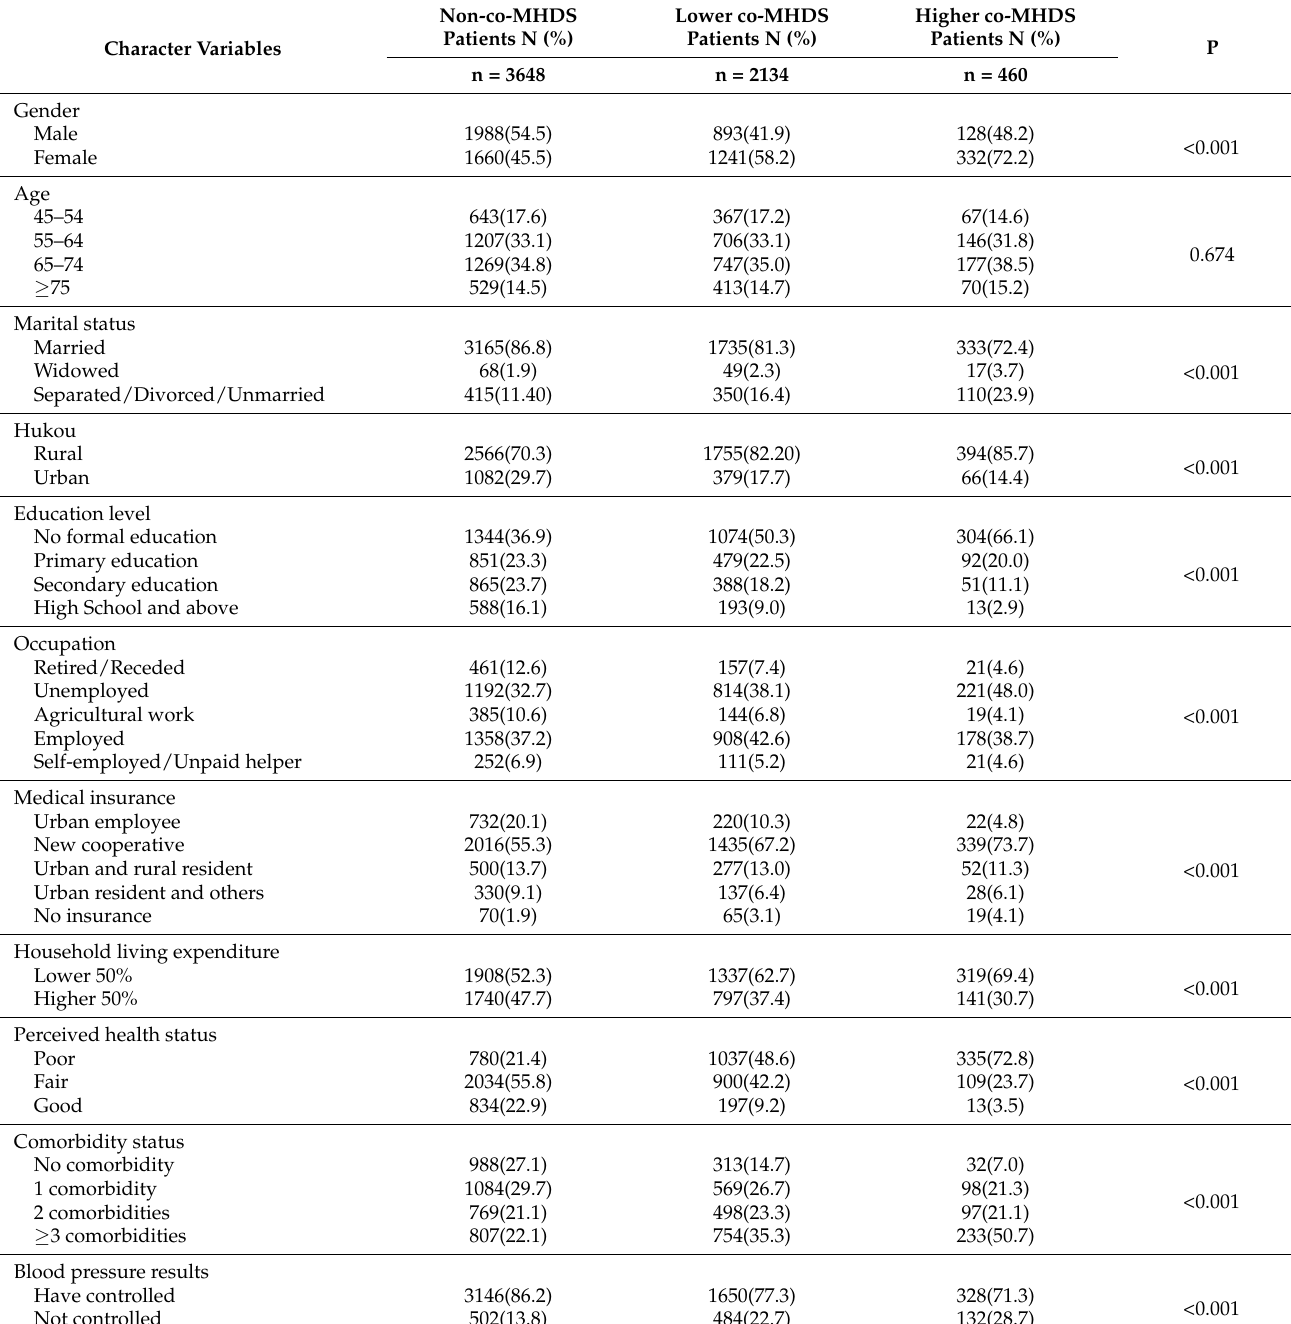
Table 1. Demographic characteristics of different depressive statuses among middle-aged and elderly people with